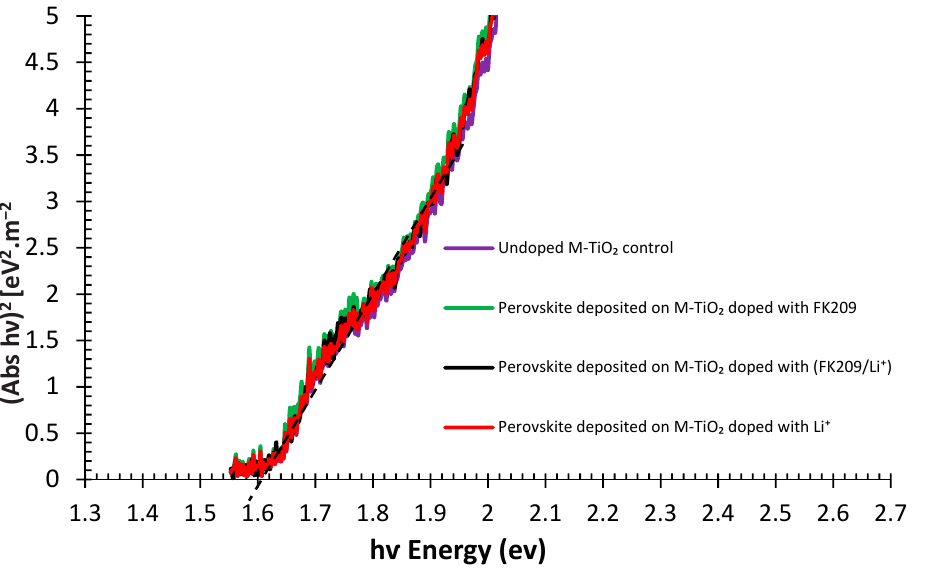
Figure 7. Energy gap of perovskite films deposited on M-TiO 2 doped with FK209, FK209/Li + and lithium, using Tauc